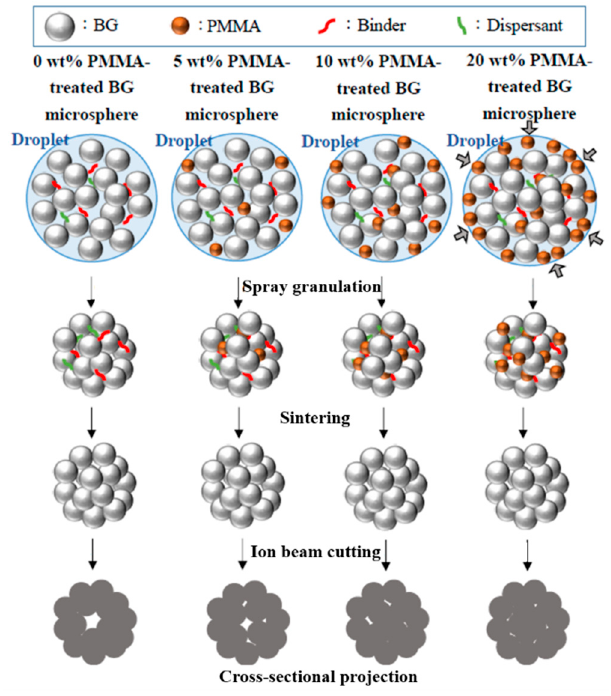
Figure 8. Schematic diagram of the formation mechanism of the PMMA-treated, granulated BG mi- crospheres.